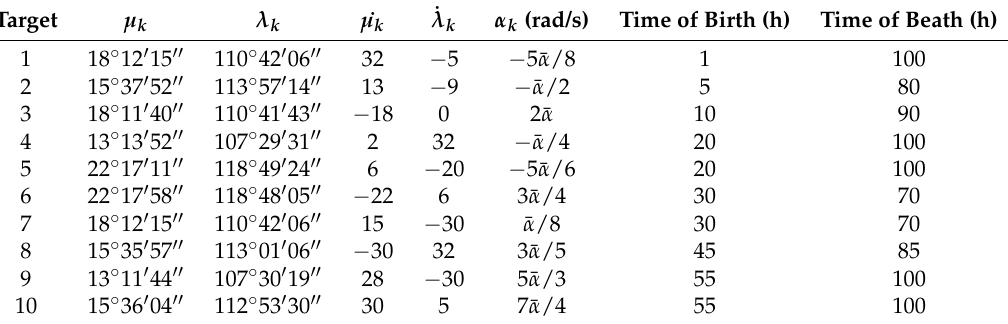
Table 1. Target initial states.